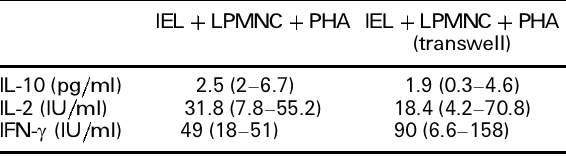
Table 1. Cytokine production by PHA-stimulated mucosal lymphocytes physically separated in a Transwell